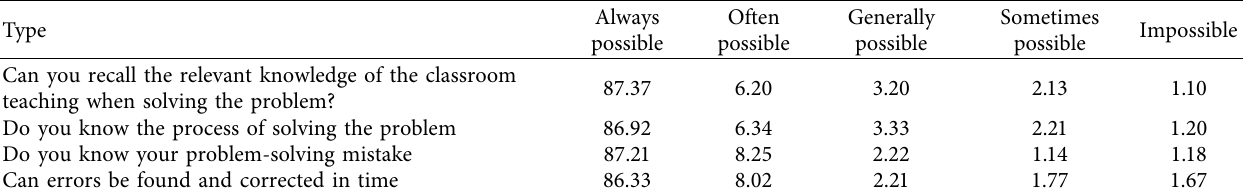
Table 2: The impact of the training system in this article on students’ autonomous learning after class. Type